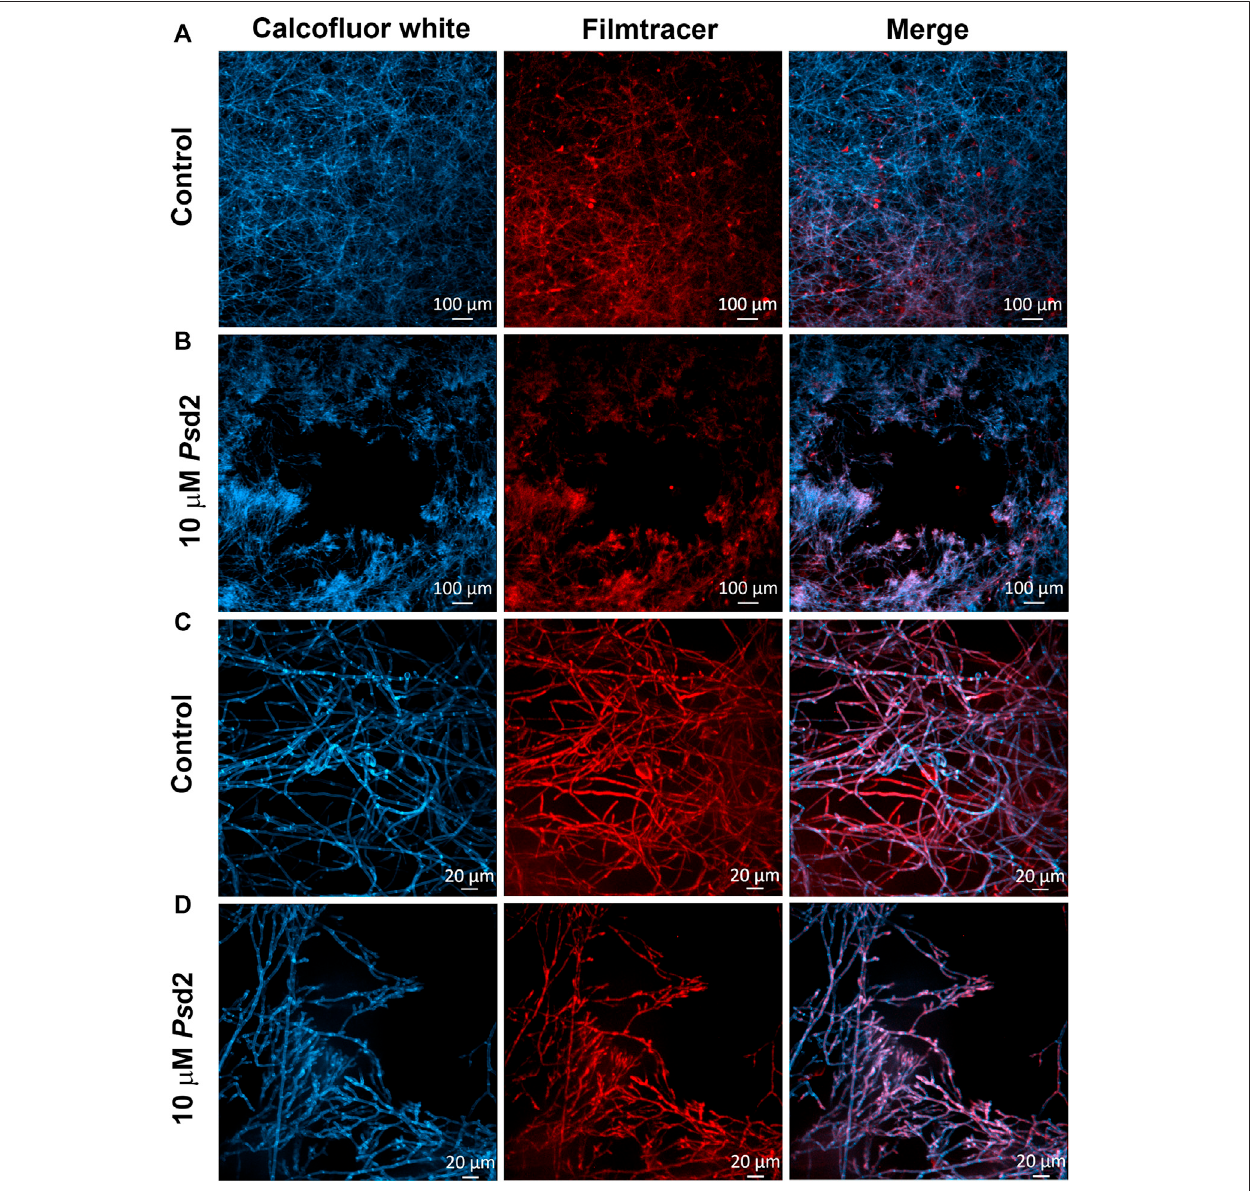
FIGURE 5 | Confocal fl uorescence microscopy images of treated A. nidulans bio fi lm with Ps d2 defensin. A. nidulans bio fi lms were grown in YUU medium at 37 ° C for 24 h in glass-bottom dishes in the absence (A,C) or presence of 10 µM Ps d2 (B,D) . After this time point, cell walls were stained with Calco fl uor White ( fi rst column) and glycoproteins with Filmtracer SyproRuby (second column). The third column represents the merge view by Calco fl uor white and Filmtracer Sypro Ruby signals. Magni fi cations of 5 x (A,B) and 20 x (C,D) were used in the panels. Scale bars represent 100 µm (A,B) and 20 µm (C,D) .